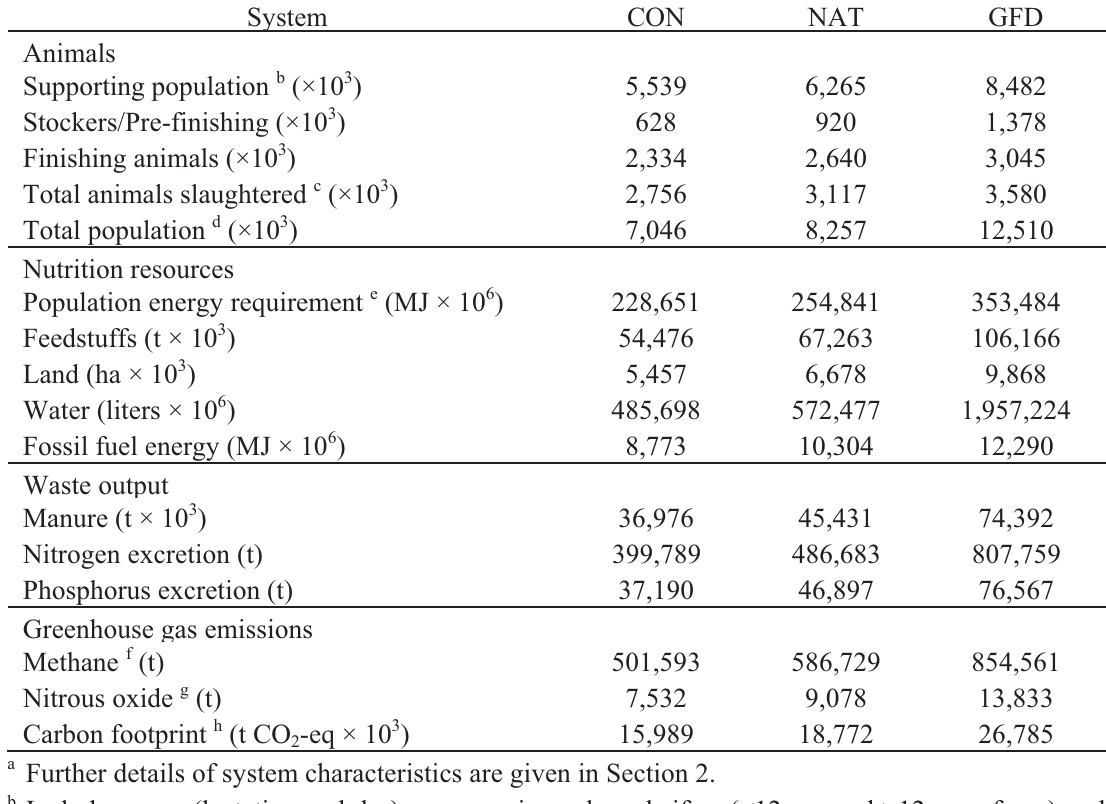
Table 2. Resource inputs, waste output and environmental impact associated with producing 1.0 × 10 9 kg of beef from a conventional (CON), natural (NAT) or grass-fed (GFD) system a